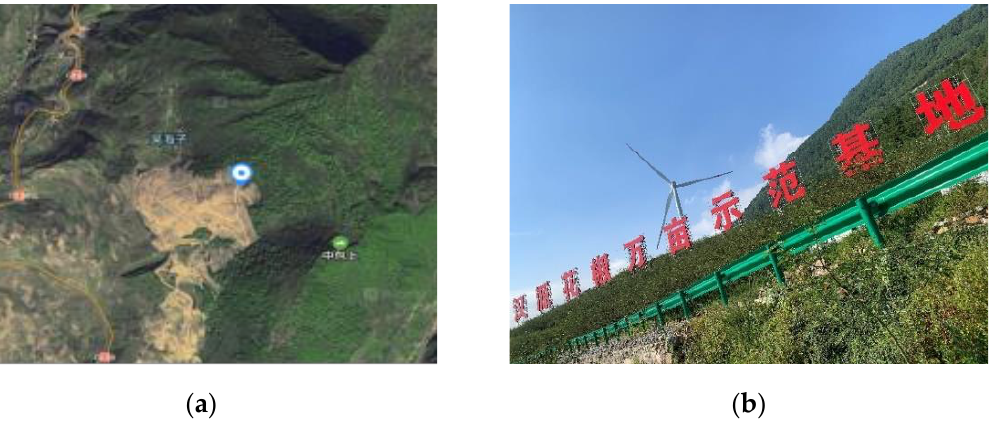
Figure 1. ( a ) Sichuan pepper planting location; ( b ) planting environment. From 10 am to 5 pm in 24 August 2021, 953 images were acquired with a total image resolution of 4032 pixels by 3024 pixels. In order to ensure the diversity of Sichuan pepper fruit samples, samples with varying light intensity, fruit numbers, and occlusion degrees were collected, as shown in Figure 2.